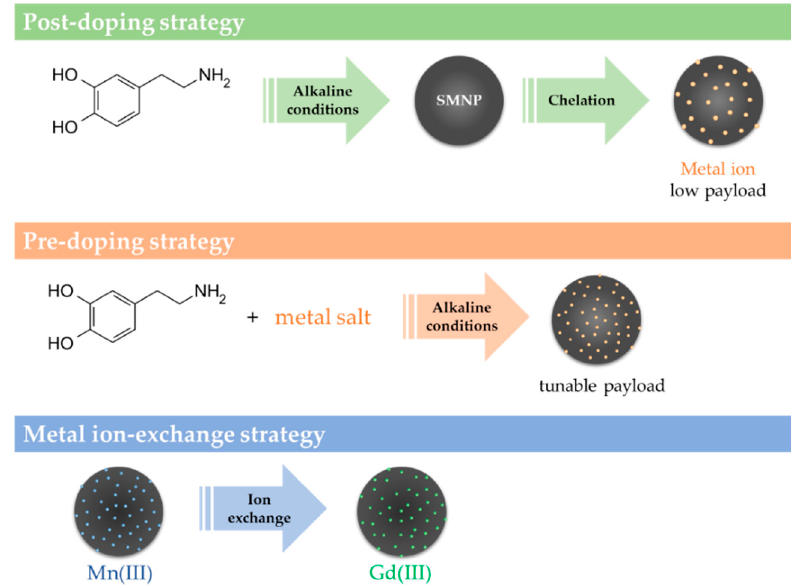
Schematic of the strategies for preparing metal ion-loaded melanin nanoparticles. SMNP synthetic melanin nanoparticles. Reproduced with permission from [52]. Copyright Elsevier, 2020.